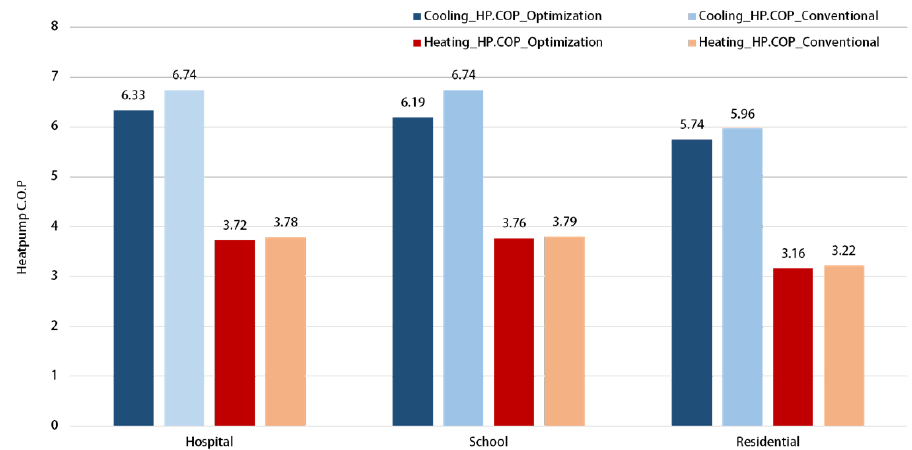
Figure 16. Comparison of the heat pump (HP) coefficient of performance (COP) according to the optimization results by building type.